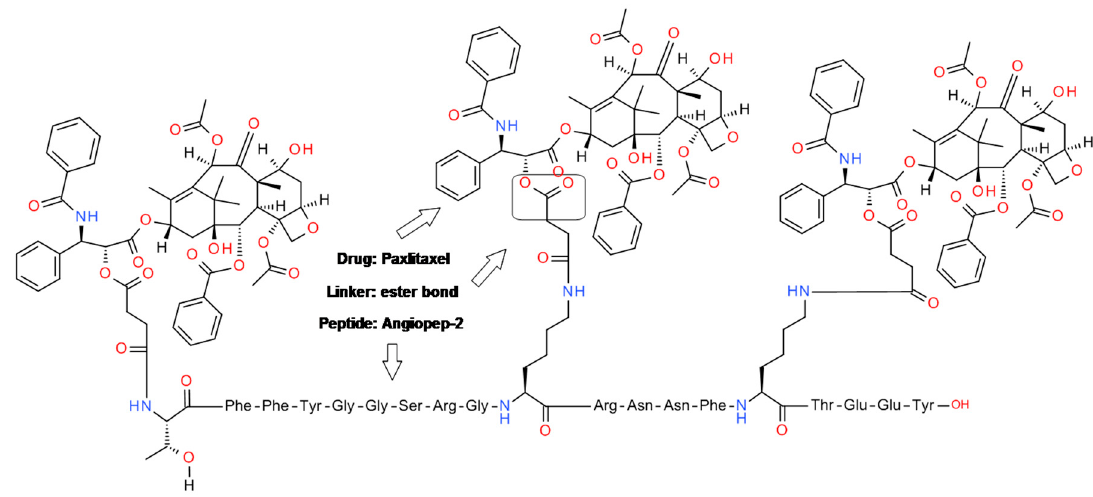
Figure 3. Chemical structure of angiopep-2-paxlitaxel conjugate (ANG1005, GRN1005).